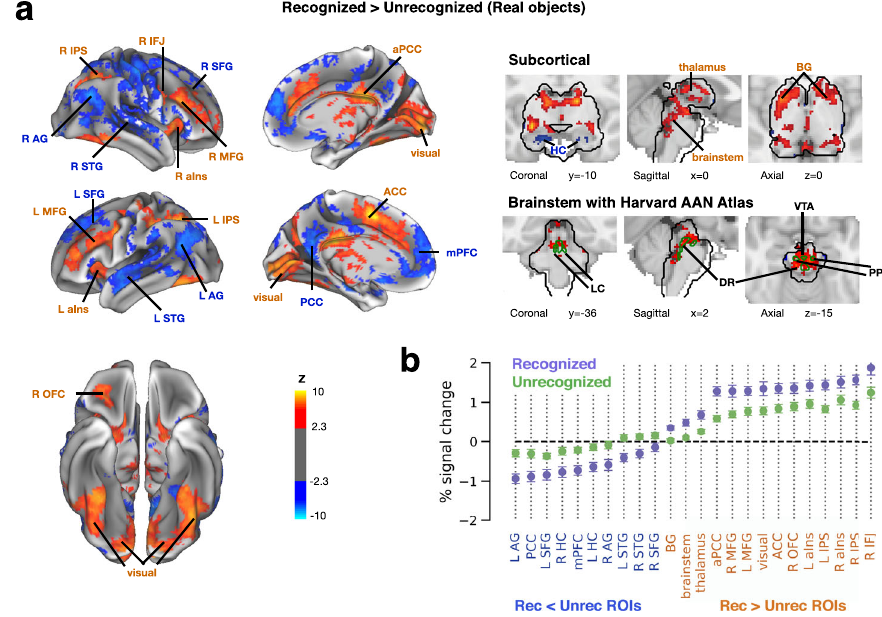
Fig. 3 Effects of subjective object recognition on BOLD response magnitudes across the brain. a Group-level GLM contrast of recognized > unrecognized objects. Left: data overlaid on a template cortical surface. Right, top: signi fi cant effects in subcortical regions (black contour). Right, bottom: signi fi cant effects in brainstem (black contour), overlaid with ROIs from the Harvard Ascending Arousal Network Atlas (green contours). Plotted on MNI152 template brain volume. Data were thresholded using cluster-based FWE-correction in FSL, with a voxel-de fi ning Z statistic threshold of p < 0.01 and a cluster size threshold of p < 0.05. b GLM-estimated percent signal change of the stimulus-triggered response, averaged across voxels within signi fi cant clusters shown in A. Blue and orange labels denote clusters with negative and positive contrast values, respectively; ROIs are sorted according to response magnitudes in recognized trials. Data are sorted by subjective recognition report, averaged across stimulus categories. Statistical testing was not performed to avoid circularity. Error bars indicate s.e.m. across subjects ( N = 25). BG: basal ganglia, IPS: intraparietal sulcus, aPCC: anterior posterior cingulate cortex, ACC: anterior cingulate cortex, aIns: anterior insula, IFJ: inferior frontal junction, MFG: middle frontal gyrus, OFC: orbitofrontal cortex, HC: hippocampus, AG: angular gyrus, PCC: posterior cingulate cortex, STG: superior temporal gyrus, SFG: superior frontal gyrus, mPFC: medial prefrontal cortex, LC: locus coeruleus, DR: dorsal raphe, VTA: ventral tegmental area, PPN: pedunculopontine nucleus, L: left, R: